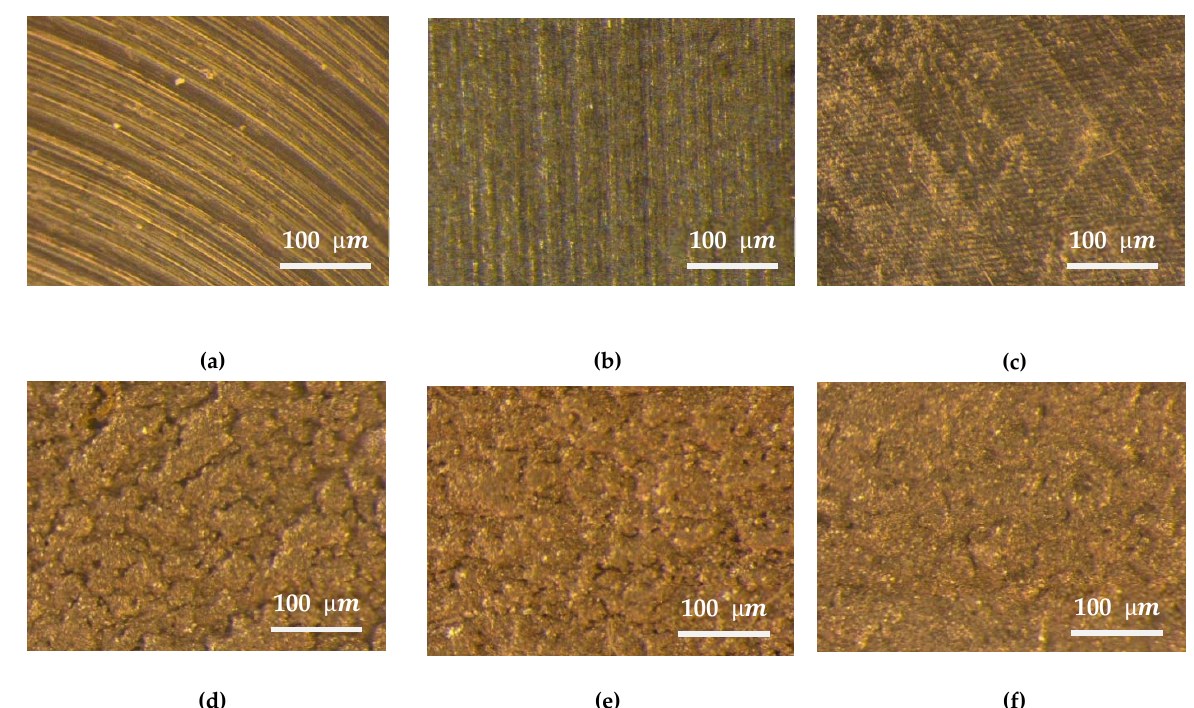
Figure 6. Microstructure structure of the additively and conventionally manufactured HXs: ( a ) CM–HX1 R a = 0.23 µ m; Figure 7 Microstructure structure of the additive and conventionally manufactured HXs: (a) CM HX1 𝑅 (cid:3028) (cid:3404) ( b ) CM–HX2 R a = 0.36 µ m; ( c ) CM–HX3 R a = 0.56 µ m; ( d ) AM–HX1 R a = 5.08 µ m; ( e ) AM–HX2 R a = 4.72 µ m; and ( f ) 0.23 µ𝑚 ; (b) CM HX2 𝑅 (cid:3028) (cid:3404) 0.36 µ𝑚 ; (c) CM HX3 𝑅 (cid:3028) (cid:3404) 0.56 µ𝑚 ; (d) AM HX1 𝑅 (cid:3028) (cid:3404) 5.08 µ𝑚 ; (e) AM HX2 𝑅 (cid:3028) (cid:3404) AM–HX3 R a = 4.42 µ m. 4.72 µ𝑚 , (f) AM HX3 𝑅 (cid:3028) (cid:3404) 4.42 µ .